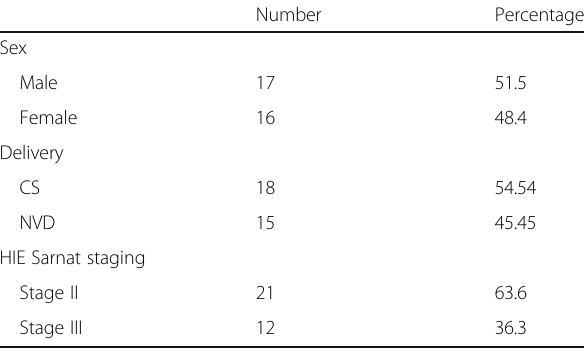
demographic data, mode of delivery, and HIE Sarnat staging ( n =